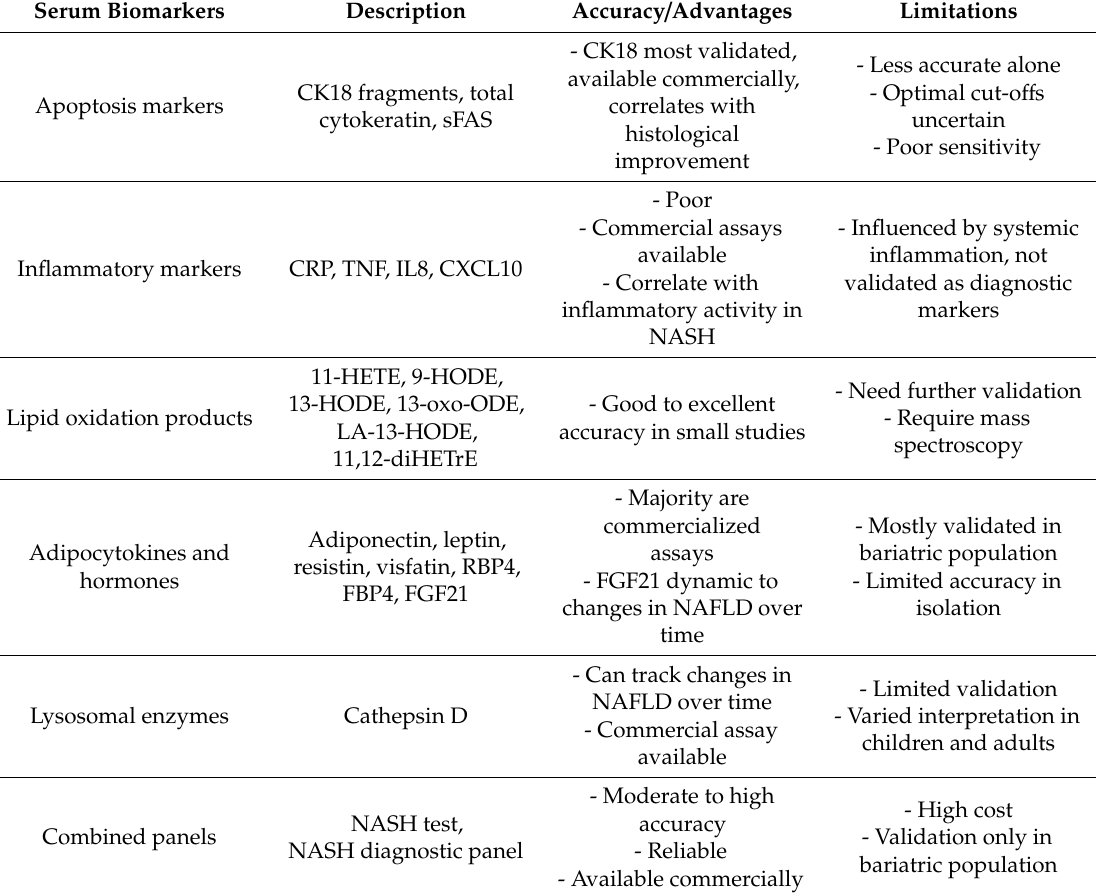
Table 2. Serum biomarkers for nonalcoholic steatohepatitis